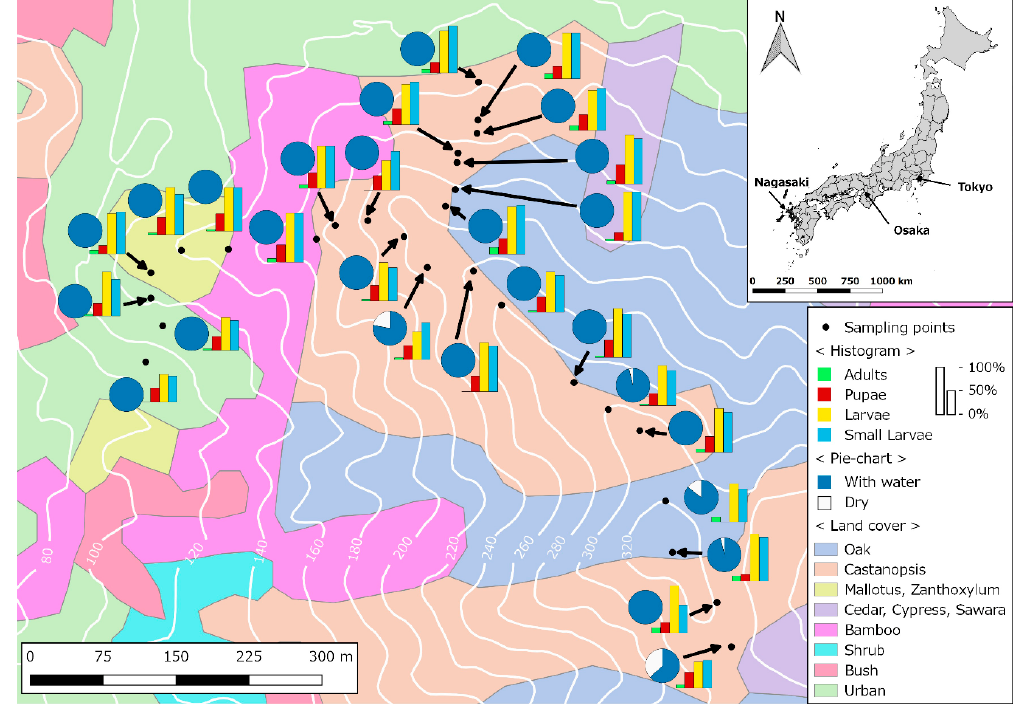
Figure 1. Bamboo mosquito, Tripteroides bambusa , persistence by stage along the altitudinal gradient of Mt Konpira. The histograms show the percentage of times a stage of Tr. bambusa was present at a sampling point, while the pie charts show the fraction of time the ovitraps had water. Map colors indicate land cover category, and white lines show the elevation in m. For further details please refer to the inset legend. In the histogram legend, ‘Larvae’ indicates fourth instar larvae, and ‘Small Larvae’ first, second, and third instar larvae. The inset map shows the location of Kyushu island in western Japan and Nagasaki city, which is west of Osaka and Tokyo, the two most important cities in Japan.